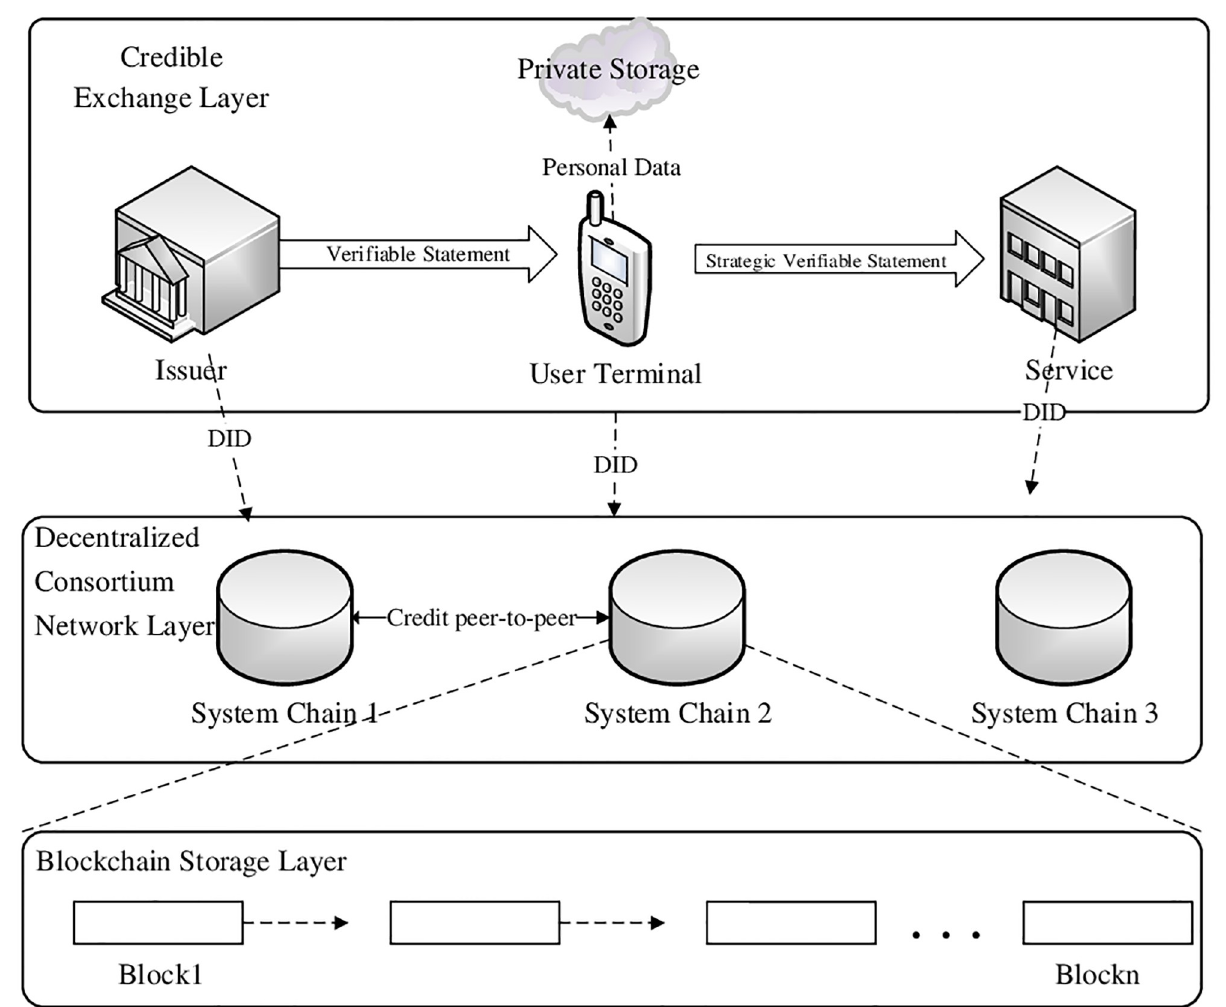
Fig 5. Framework of SDPP-SSI